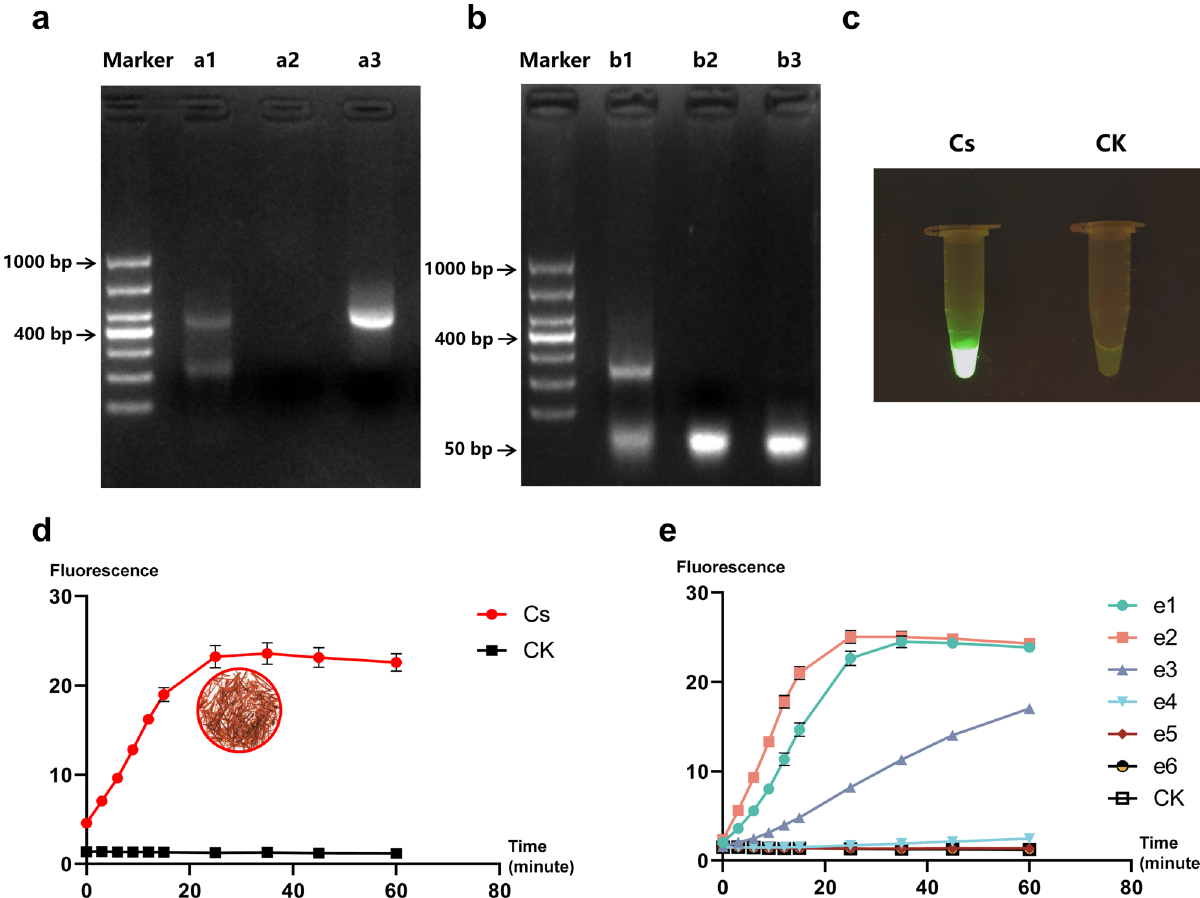
Fig. 3 Feasibility, speci fi city and sensitivity of GAGE. a Endonuclease activity of Cas12a. Lane Marker: DL1000 (Takara Biomedical Technology (Beijing) Co., Ltd., China); Lane a1: Cas12a + Cs_crRNA + ITS2 fragments of Crocus sativus ; Lane a2: Cas12a + Cs_crRNA: Lane a3: ITS2 fragments of Cr. Sativus . b Collateral cleavage activity of Cas12a. Lane b1: Cas12a + Cs_crRNA + ITS2 fragments of Cr. sativus + 50 bp ssDNA; Lane b2: 50 bp ssDNA; b3: Cas12a + Cs_crRNA + 50 bp ssDNA. c Fluorescence signal of GAGE. The two groups were incubated at 37 °C for 25 min and detected by excitation with 470 nm light. Cs: Cas12a + Cs_crRNA + ITS2 fragments of Cr. sativus + ssDNA reporter; CK (negative control): Cas12a + Cs_crRNA + H 2 O + ssDNA reporter. d Speci fi city of GAGE. The plant materials in the circle are the stigma of saffron. The DNA substrate of two groups were as follows: Cs: ITS2 fragments of Cr. sativus and CK (negative control): nuclease-free water. e Sensitivity of GAGE. The seven groups had different concentration of DNA substrates (ITS2 fragments of Cr. sativus ), e1: 10 ng/ μ L; e2: 1 ng/ μ L; e3: 0.1 ng/ μ L; e4: 0.01 ng/ μ L; e5: 0.001 ng/ μ L; e6: 0.0001 ng/ μ L and CK (negative control): 0 ng/ μ L. All plots data represented means + / − standard deviation (SD) from three independent